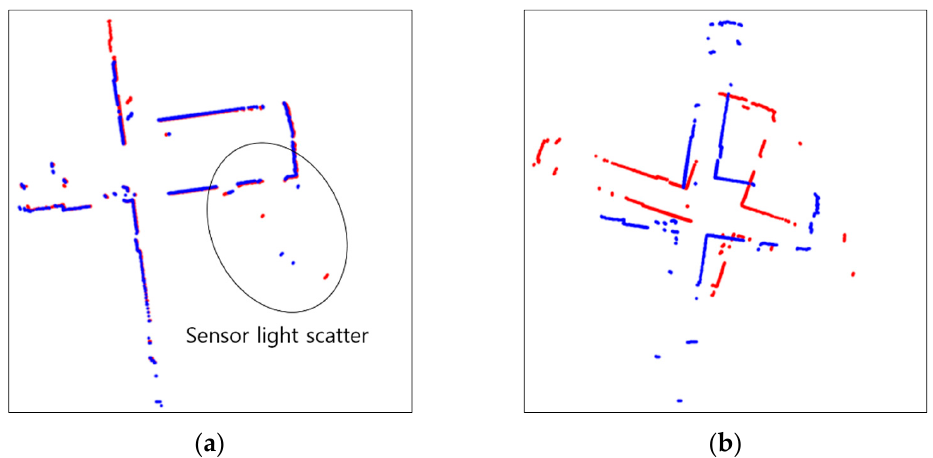
Figure 15. Scan matching images in environment 3 (Red: Previous scan, blue: current scan). ( a ) Normal matching images; ( b ) faulty matching images.